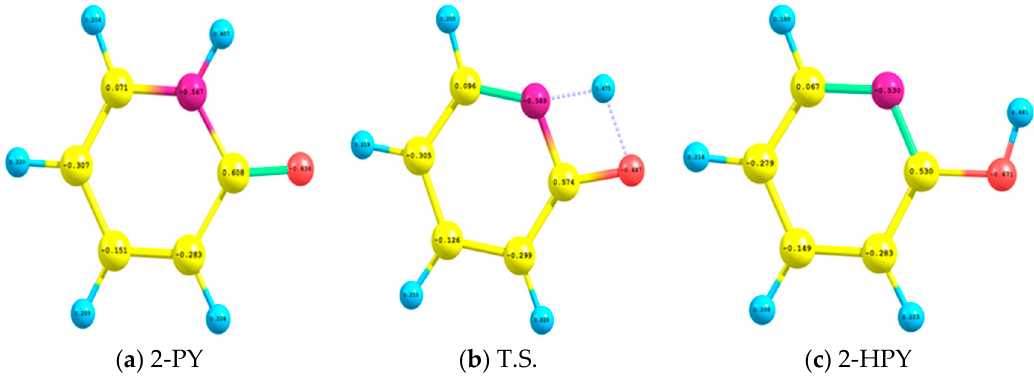
Figure 3. The natural atomic charges of ( a ) 2-hydroxypyridine (2-PY); ( b ) the transition state (T.S.); and ( c ) 2-pyridone (2-HPY) which were calculated by utilizing CAM-B3LYP/aug-cc-pvdz level of theory. For color scheme see caption of Figure